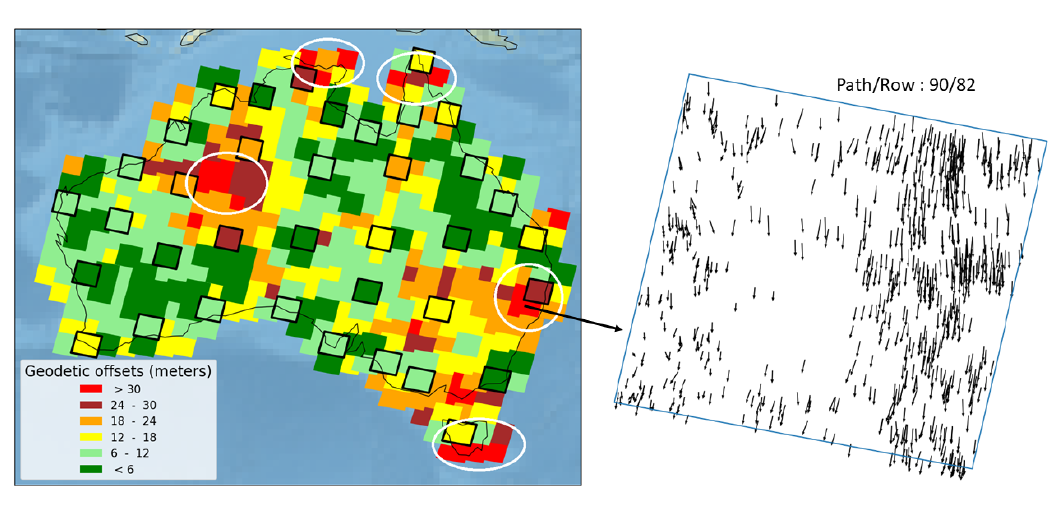
Figure 2. Plot of geodetic accuracy of Landsat 8 scenes prior to the triangulation procedure. The geodetic offsets are shown for each of the 394 scenes in the Australia block (left). A small number indicates that the Landsat 8 scene’s positional accuracy is consistent with the GLS ground control points (GCPs), and a large number suggests inconsistencies between the scene’s pointing accuracy and the GLS GCPs. The anchor sites are shown using black outline, and the regions where GLS GCPs are expected to have poor positional accuracy are shown in white ellipses. The vector plot on the right shows the magnitude and direction of the geodetic offsets (residuals) for each of the GCPs for a particular path/row (90/82). The magnitude of the residuals is scaled by a factor of 300 for visual purposes. The downward-pointing arrow denotes a large systematic bias in the along-track direction. The mean geodetic offsets were − 3.1 m and − 31.9 m in the across- and along-track directions, respectively, for the particular scene used in this procedure